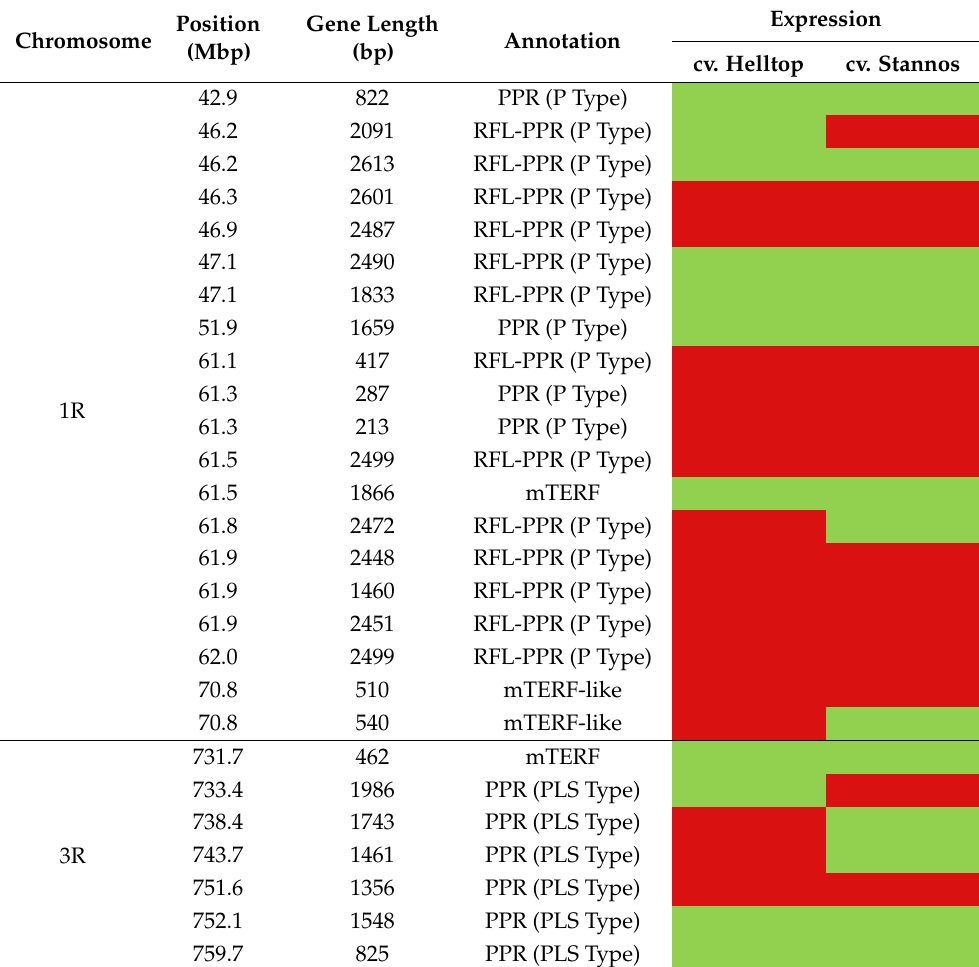
Table 1. Pentatricopeptide repeat protein (PPR) and mitochondrial transcription termination factor (mTERF) genes in restoration of male-fertility-associated regions identified on 1RS (40–70 Mbp) and 3RL (710–760 Mbp) chromosome in ‘Lo7’ rye ( Secale cereale L.) reference genome. Genes expressed in ‘Gülzow’ type hybrid cultivars at flowering are marked as green, and genes not expressed as red. Expression Position Gene Length Annotation Chromosome (Mbp) (bp) cv. Helltop cv. Stannos 42.9 822 PPR (P